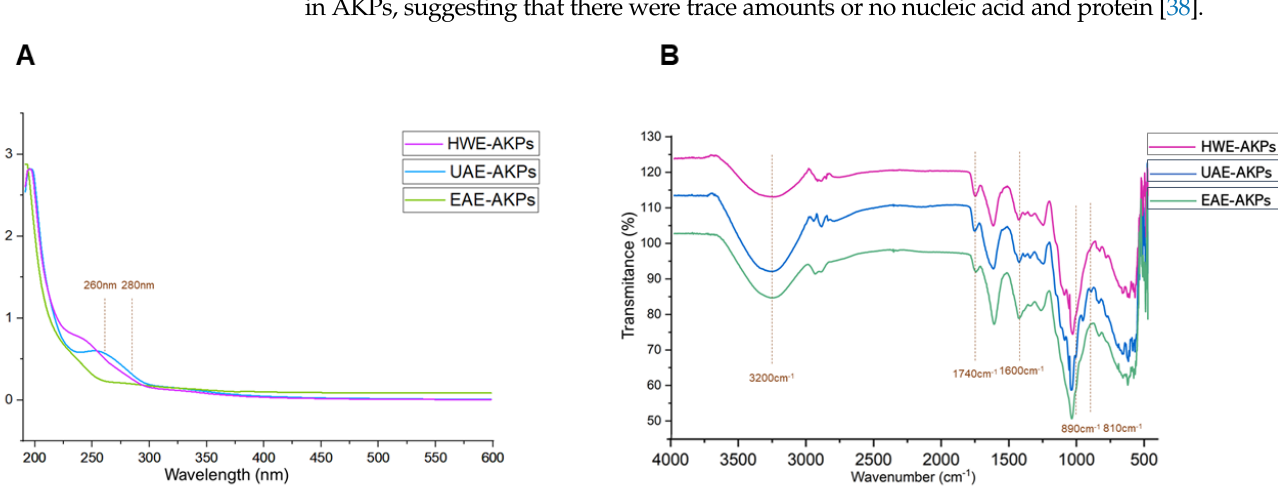
Figure 1. UV spectra( A ) and FT-IR spectra ( B ) of three AKPs extracted by different extraction meth-